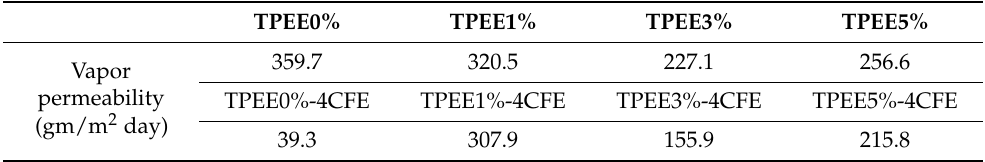
Table 3. Vapor permeability of TPEEn% and TPEEn%-4CFE.